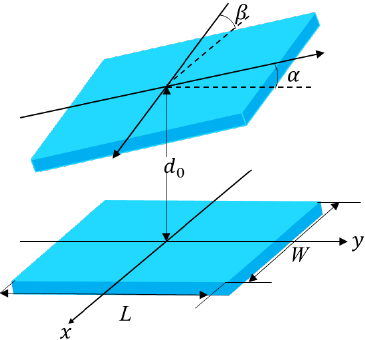
Figure 2. Diagram of two electrodes with relative